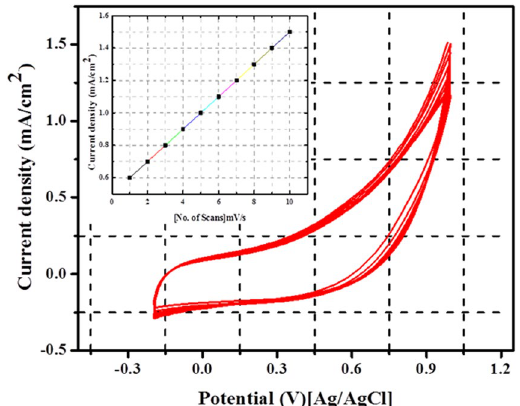
Figure 5. Cyclic voltammograms for the obtained core@shell (ZnO@C) microspheres in 1 M KOH at the scan rate of 50 mV/s; inset image: dependency of the current density on the number of CV cycles (1 to 10 cycles).